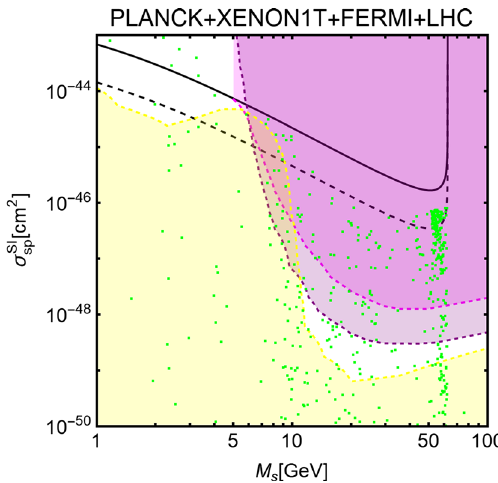
Fig. 7 Model points, from the general parameter scan illustrated in the main text, complying with all DM constraints, namely correct relic den- sity, DM-nucleon cross-section below XENON1T limit and DM anni- hilationcross-sectioncompatiblewithIDandCMBlimits,adleadingto an invisible Higgs branching ratio of 2 . 5% ≤ BR ( H 1 → X X ) ≤ 11%. The magenta and purple regions correspond to the sensitivity of the XENONnT and DARWIN experiments while the yellow region rep- resents the neutrino floor. Finally the solid and dashed black curves correspond to the SI DM scattering cross-section, as computed in the EFT scalar Higgs-portal, requiring that the value of the DM/SM Higgs coupling leads to values of the invisible Higgs branching fraction of 11% (solid black line) and 2 . 5% (dashed black line)